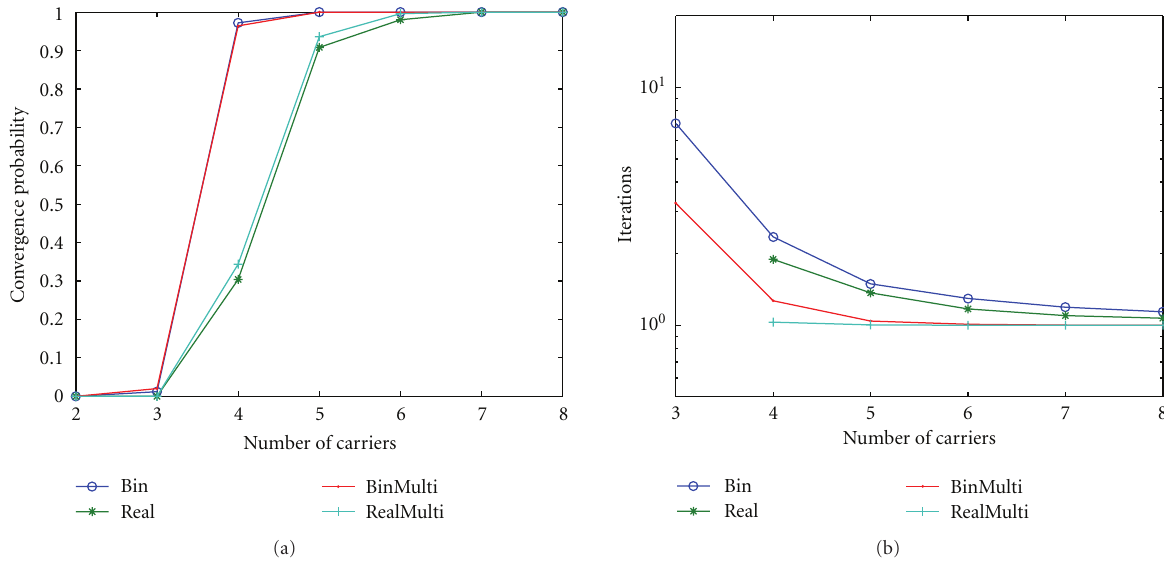
Figure 3: Convergence properties versus number of PCIs for di ff erent autonomous Primary Component Carrier Selection algorithms. (a) Convergence probability. (b) Number of iterations for convergence (only converged drops considered).